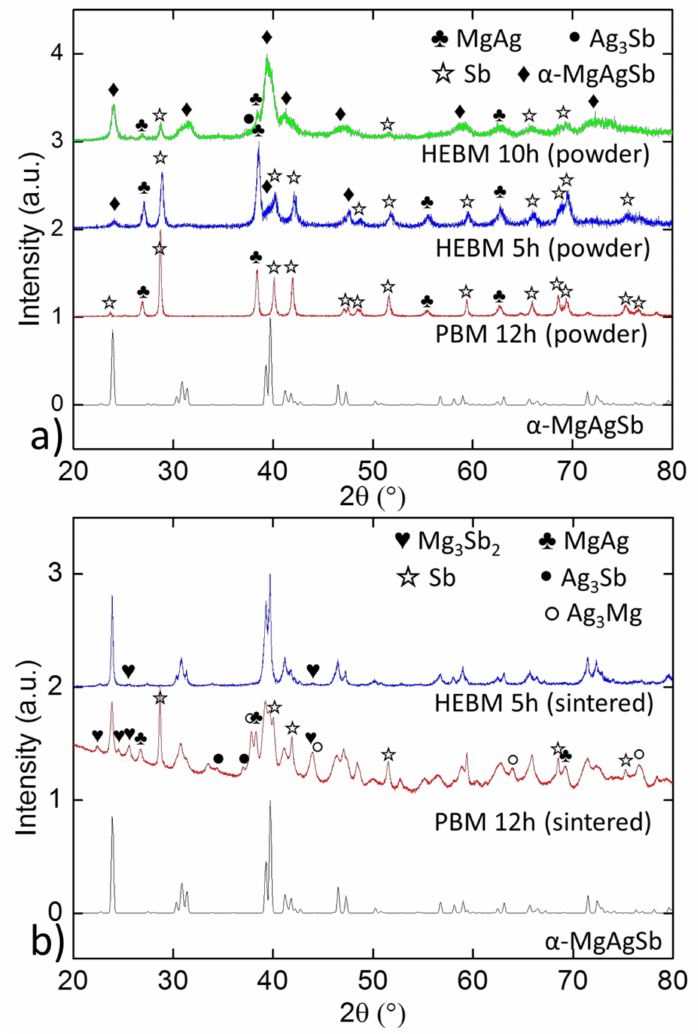
Figure 1. XRD patterns of powders ( a ) and sintered samples ( b ) comparing high energy ball-milling with planetary ball-milling and the theoretical pattern of α -MgAgSb